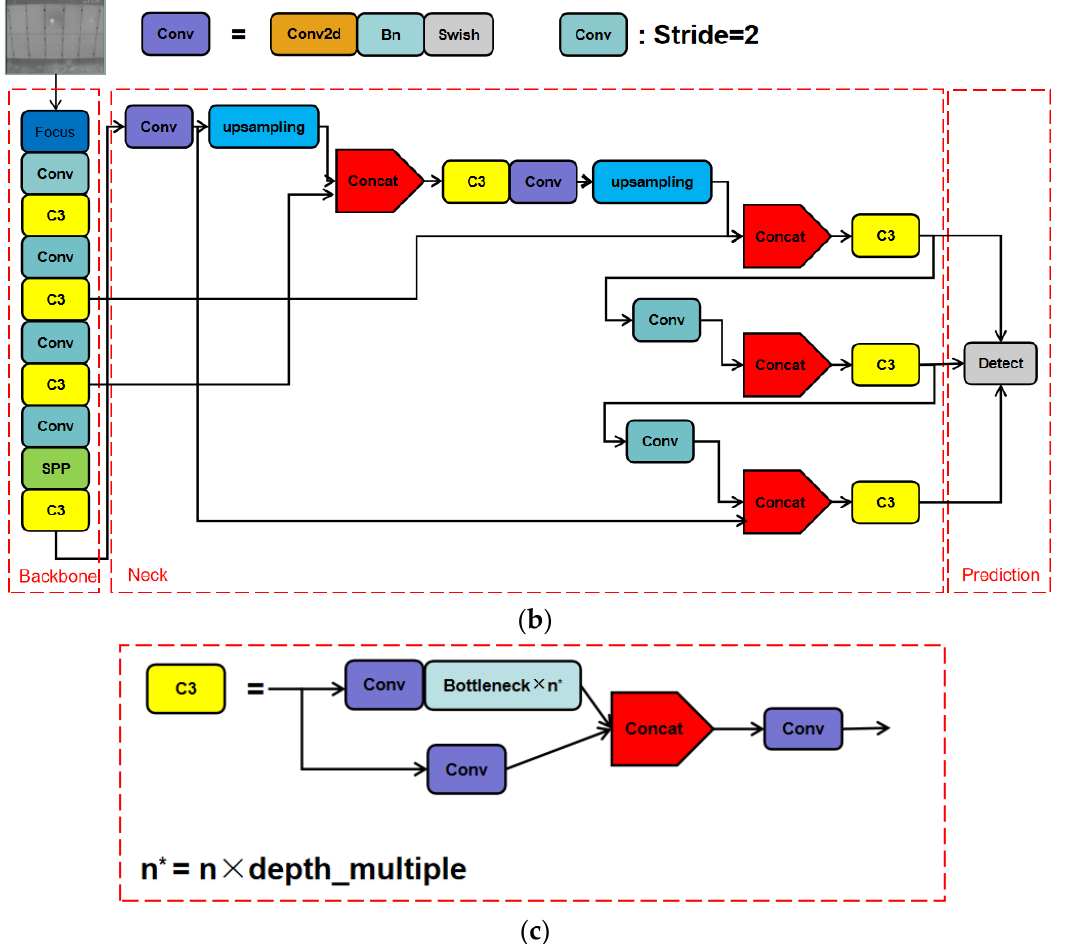
Figure 1. ( a ) Architecture of Bottleneck and SPP. ( b ) Architecture of YOLOv5 network. ( c ) Architecture of C3.